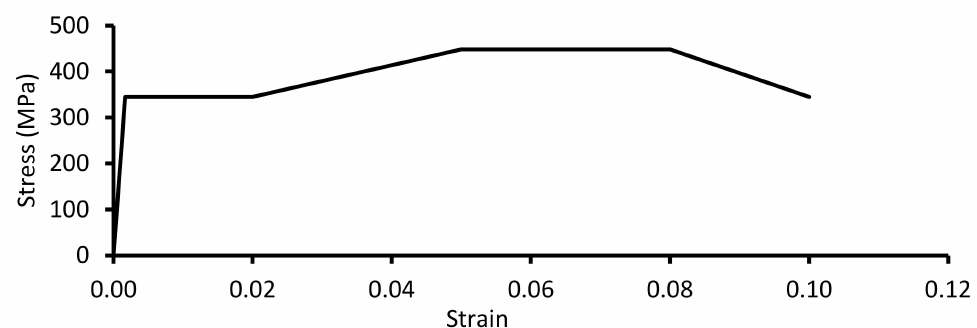
Figure 10. Average stress–strain curves for the aluminum strips.